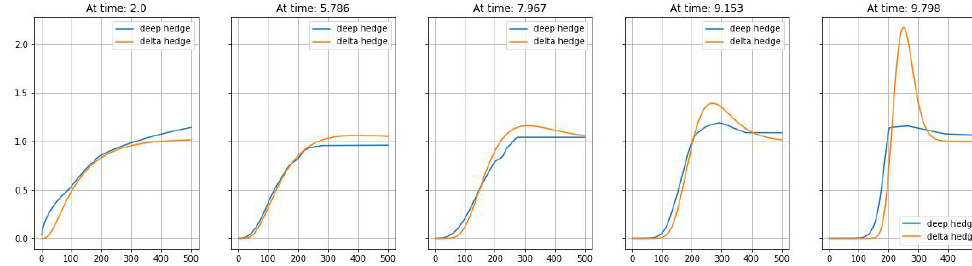
Figure 2. Hedging strategy ( p = 1).